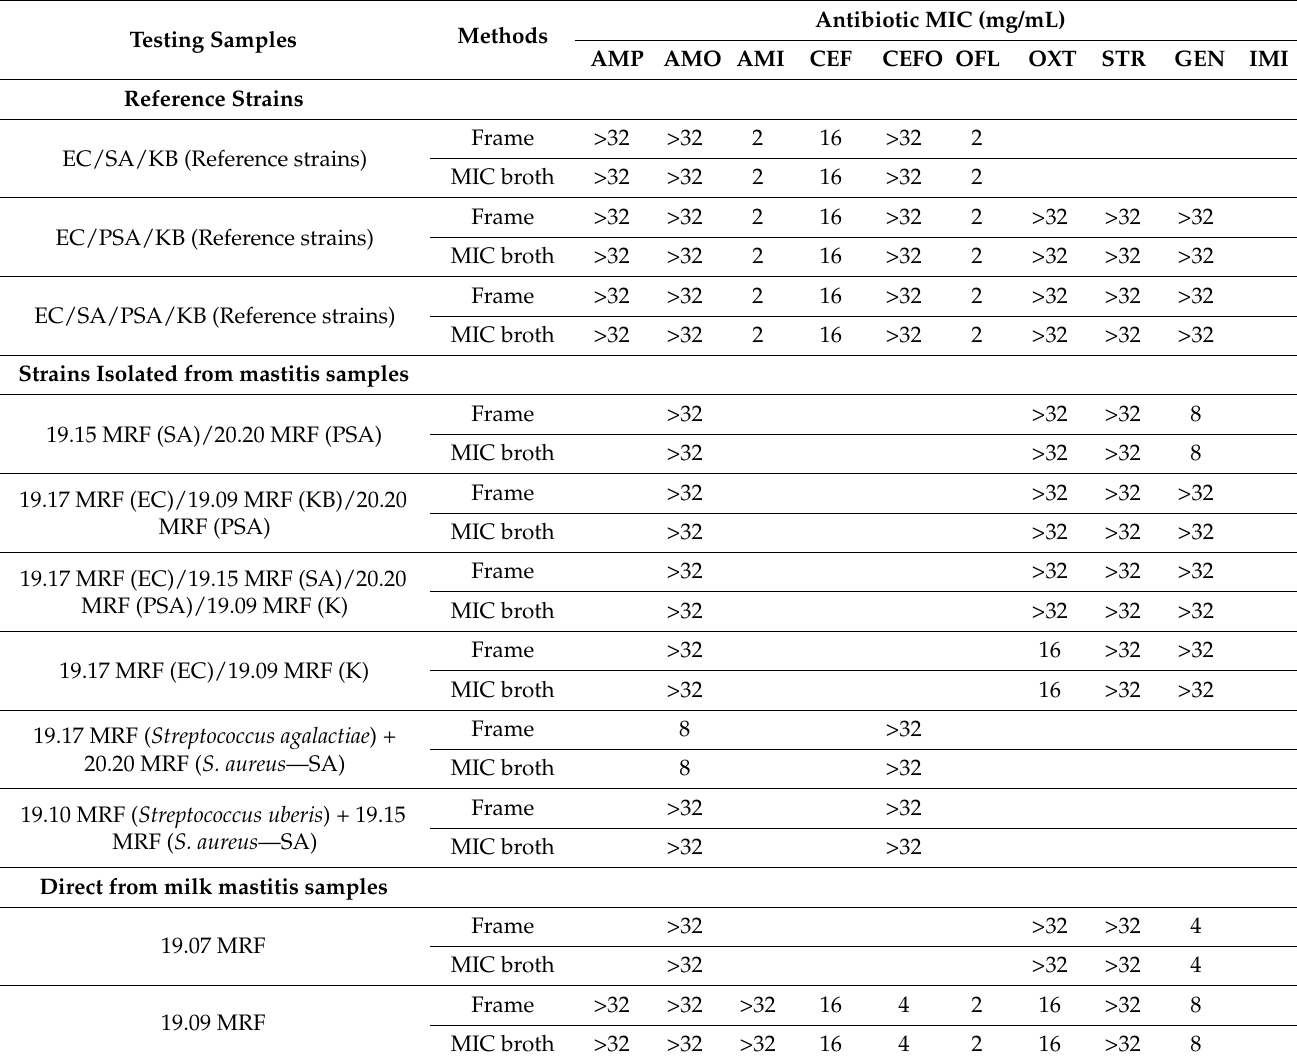
Table 2. Measure the impact of mixtures pathogens to antibiotic resistance on reference strains and mastitis